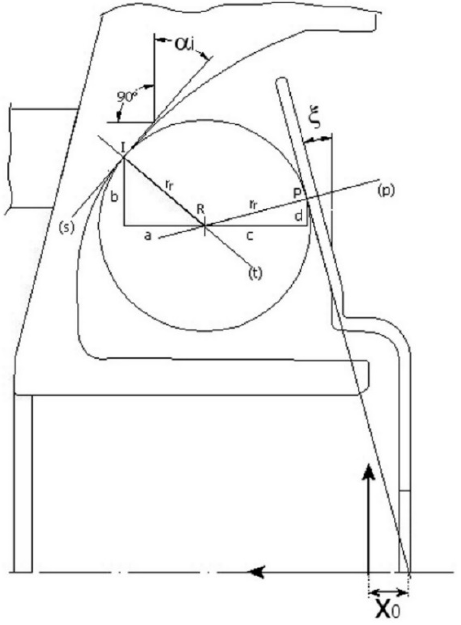
Figure 11. The coordinate system adopted.